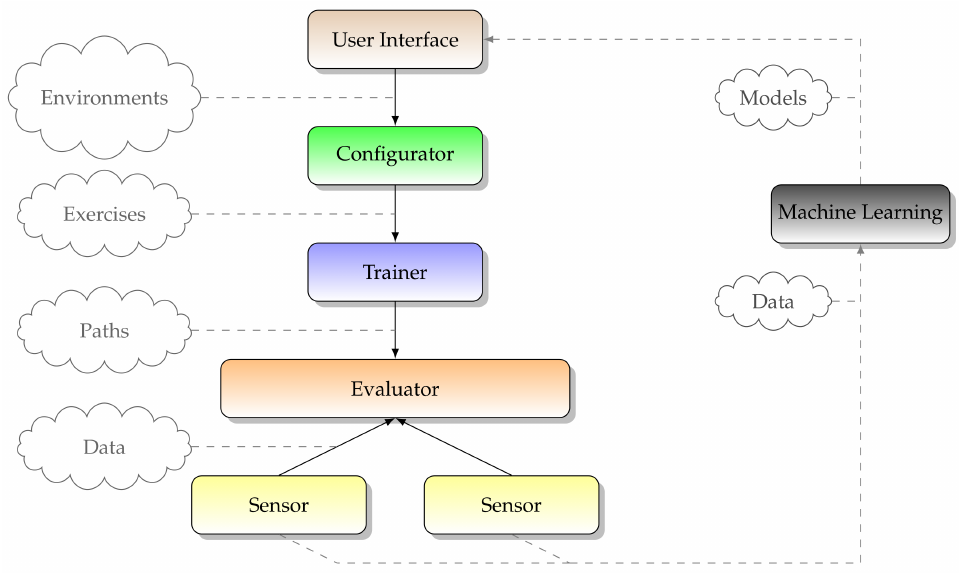
Figure 2. Logic model of system